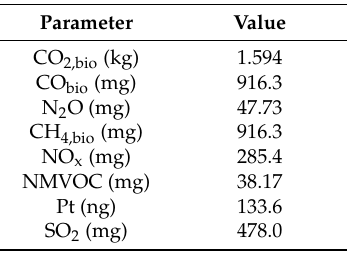
Table 2. Direct emissions in air of internal combustion engines per kWh.